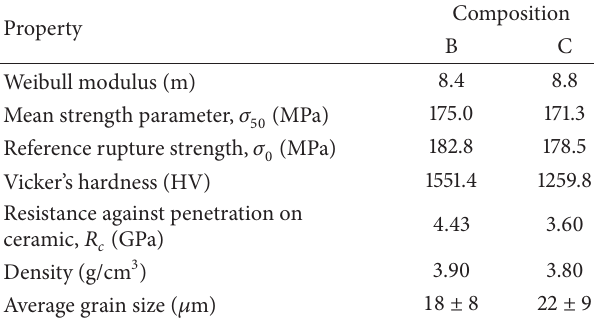
Table 3: Mechanical and physical properties of the ceramic plates.